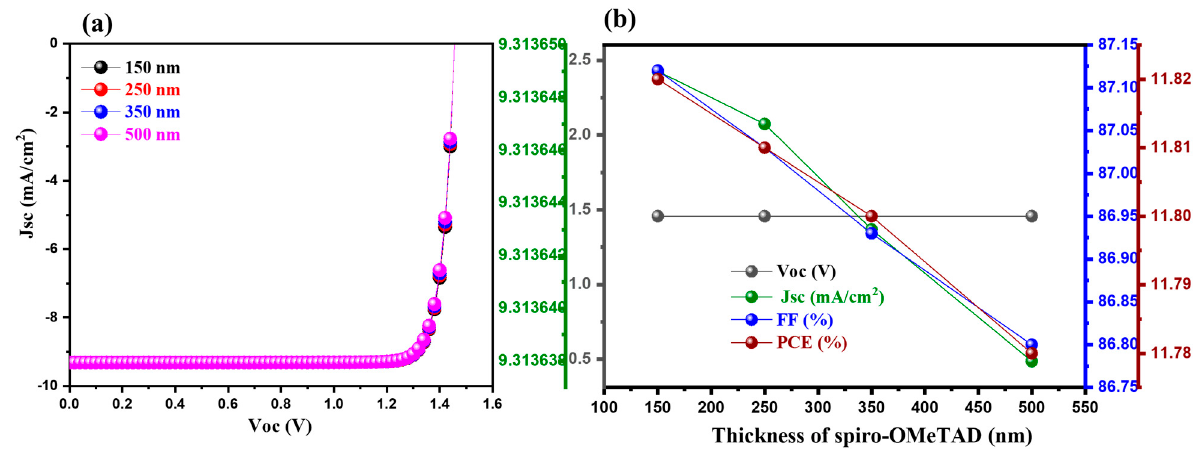
Figure 2. J–V responses ( a ) and photovoltaic parameters ( b ) of the FTO/TiO 2 (150 nm)/MA 3 Sb 2 I 9 (250 nm)/spiro-OMeTAD(150–350 nm).